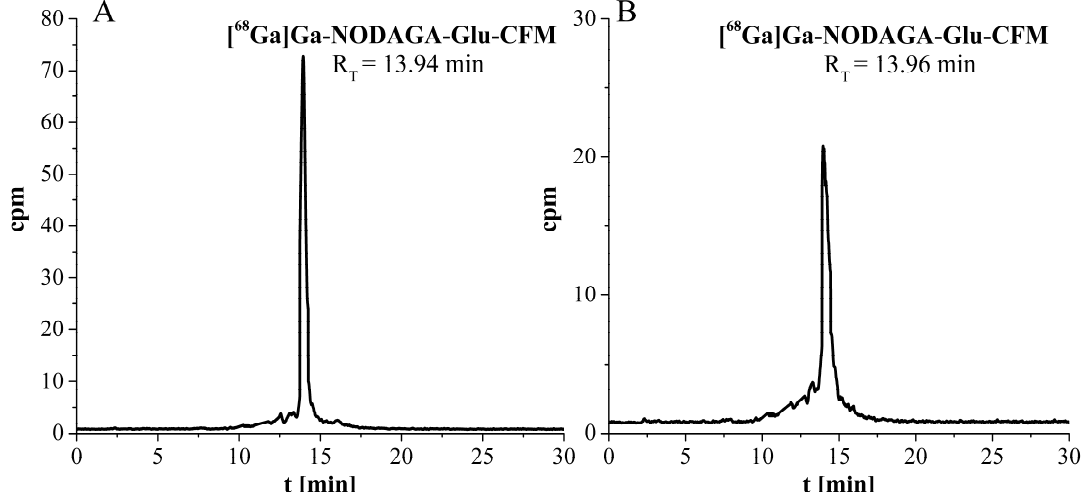
Figure 10. The HPLC radiochromatograms of the [ 68 Ga]Ga-NODAGA-Glu-CFM radioconjugate recorded after ( A ) 0.5 h and ( B ) 2 h of incubation at 37 °C in human serum.